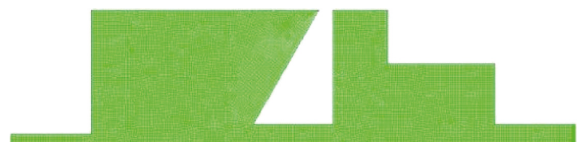
Figure 7: Grid division of Helmholtz+organ pipe cavitation nozzles.